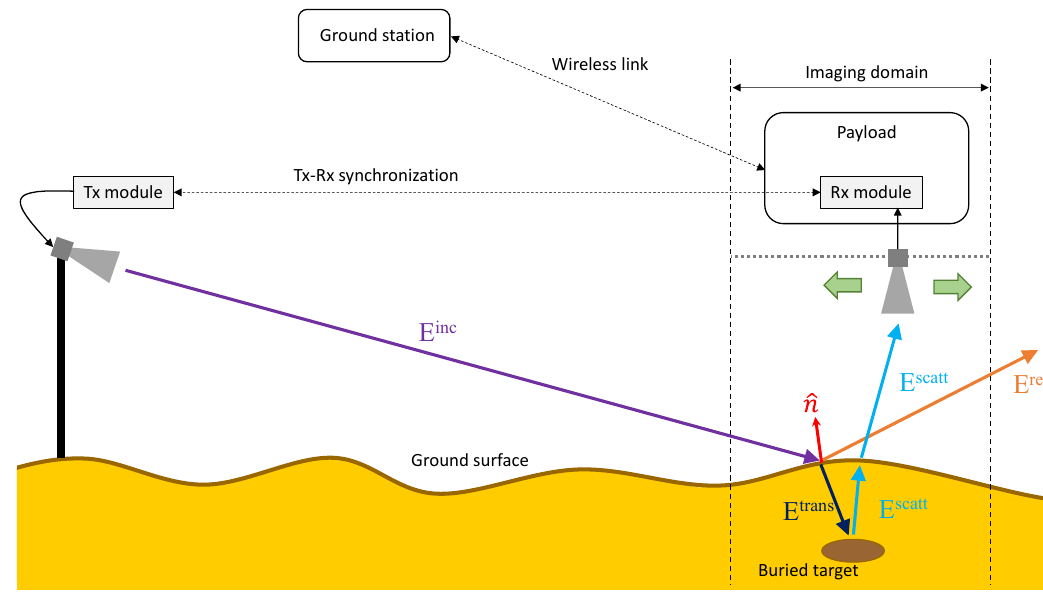
Figure 3. Scheme of the proposed hybrid FLGPR-DLGPR.